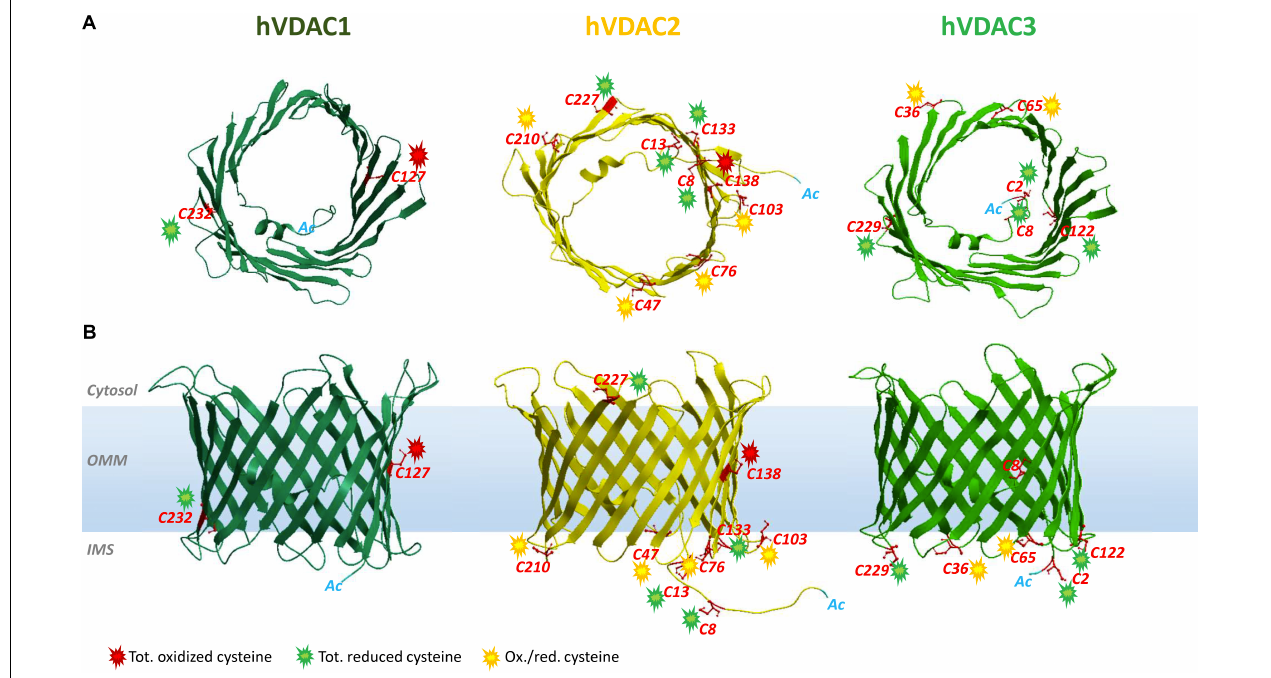
FIGURE 1 | Structure of human VDAC isoforms highlighting cysteine residues and their preferred oxidation states. The structures of hVDAC2 (yellow) and hVDAC3 (light green) β -barrels were modeled using the structure of hVDAC1 [dark green (PDB ID: 2JH4)] as a template. (A) Top view of hVDACs with the N-terminal α -helix folded within the pore. (B) Side view of the β -barrels embedded in the OMM. The cysteine residues are highlighted (in red), and their oxidative state is indicated by colored sparks: green (totally reduced), red (totally oxidized), or yellow (red/ox, i.e., partially oxidized). There are no VDAC cysteines in the outer face of the membrane, exposed toward the